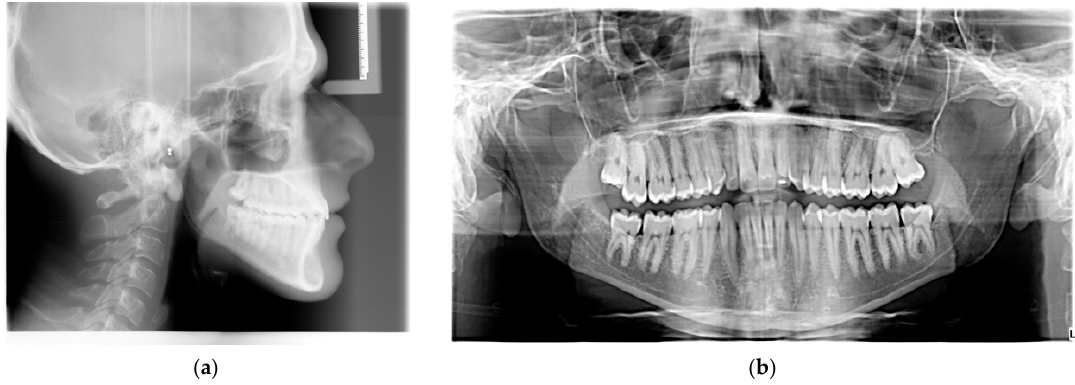
Figure 6. ( a ) Lateral cephalogram and ( b ) panoramic radiograph at the end of the treatment.